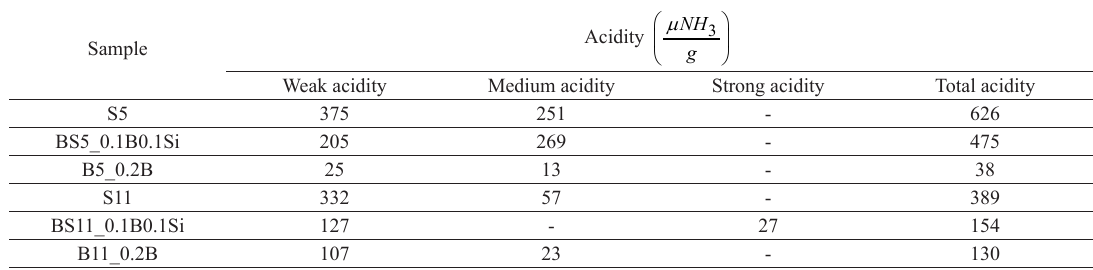
Table 5. Acidity of samples of AFI/AEL structures with different compositions.